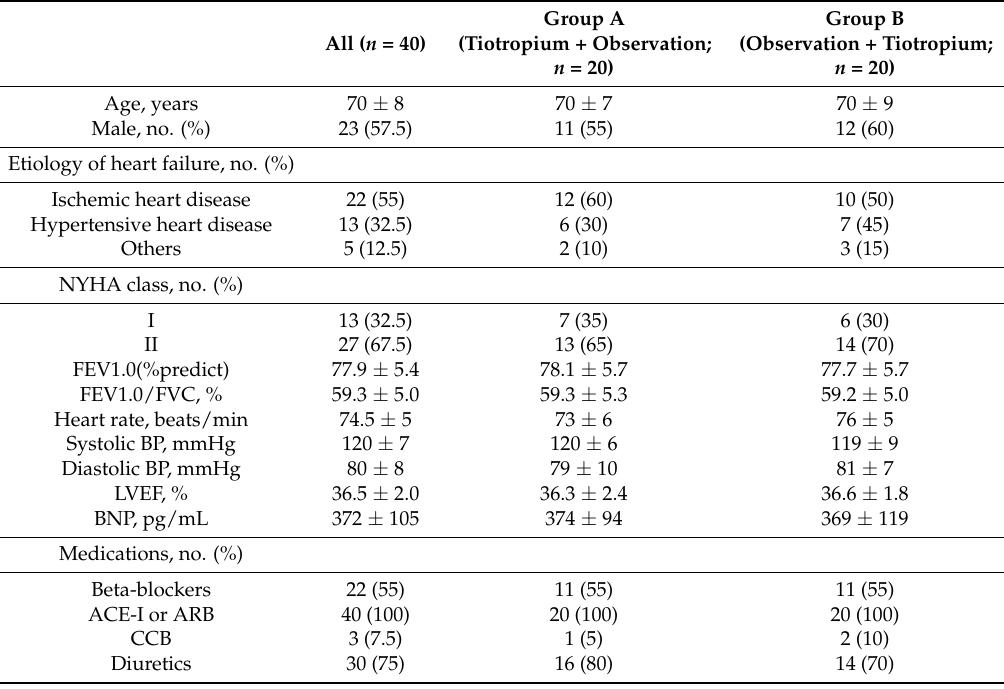
Table 1. Patient